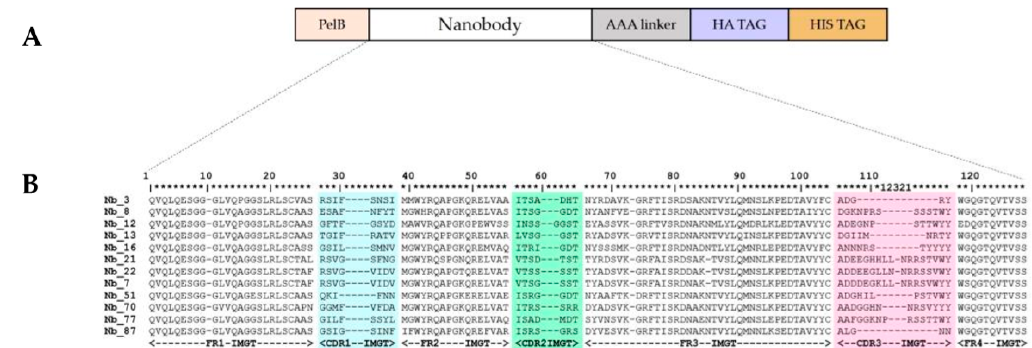
Figure 1. ( A ) Schematic representation of an Nb in the phagemid vector pMECS. Downstream of the PelB secretion sequence, the Nb-sequence is followed by a triple alanine linker, a hemagglutinin (HA), and hexa-histidine (His) tags. ( B ) Amino acid sequences of the anti-CD33 Nbs (numbering according to IMGT) [25]. The CDR1, CDR2, and CDR3 regions are highlighted in cyan, green, and pink, respectively. The amino acid sequence of the CDR3 region is displayed in alphabetical order. Position 10 in the framework region-1 (FR1-IMGT) and position 73 in the FR3-IMGT are gaps introduced to align to other V-GENE groups or subgroups. For Nb_7, Nb_21, and Nb_22, an amino acid deletion relative to other sequences occurred at position 85 (represented by a dash).